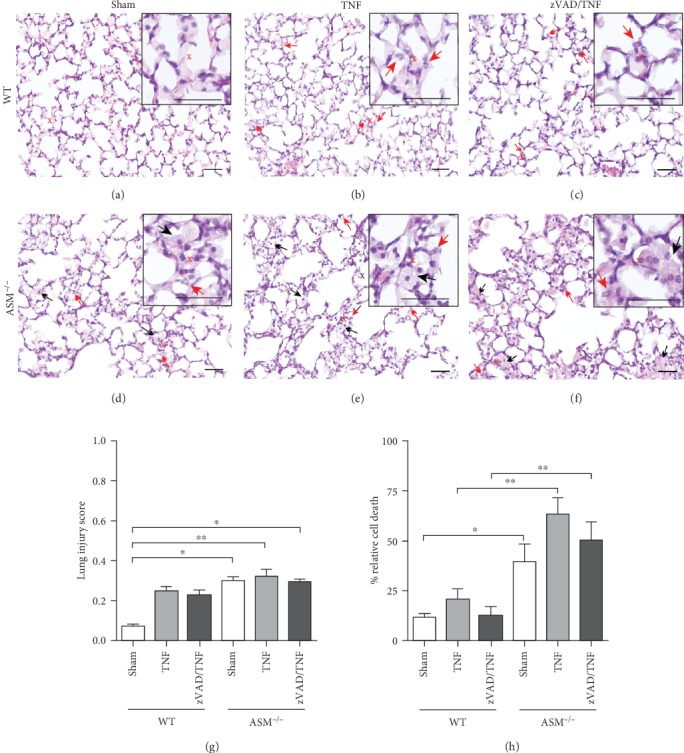
Lung histopathology and cell death. Representative HE-stained sections from (a–c) WT mice and (d–f) ASM−/− mice, treated as indicated above the image. Scale bars 50 μm, magnification 200x. Enlarged sections are shown in the upper right corners (scale bars 50 μm). The center is indicated by a red cross in the original image. Red arrows indicate interstitial neutrophils; black arrows indicate foam cells. (g) The lung injury score was assessed according to [29] by evaluating 10 fields per lung regarding the following criteria: neutrophils in the alveolar space, neutrophils in the interstitial space, hyaline membranes, proteinaceous debris in the airspaces, and alveolar septal thickening. Data are shown as mean + SEM with n = 6 in the group ASM−/− sham and n = 5 in all other groups. ∗p < 0.05, ∗∗p < 0.01. (h) Cell death was quantified in homogenized lung tissue using an ELISA against mono- and oligonucleosomes and is shown as % per mg lung tissue relative to a 100% control provided with the assay. Data are shown as mean + SEM with WT sham (n = 5), WT+TNF (n = 5), WT+zVAD/TNF (n = 4), ASM−/−+TNF (n = 5), ASM−/− sham (n = 6), and ASM−/−+zVAD/TNF (n = 5). ∗p < 0.05, ∗∗p < 0.01.